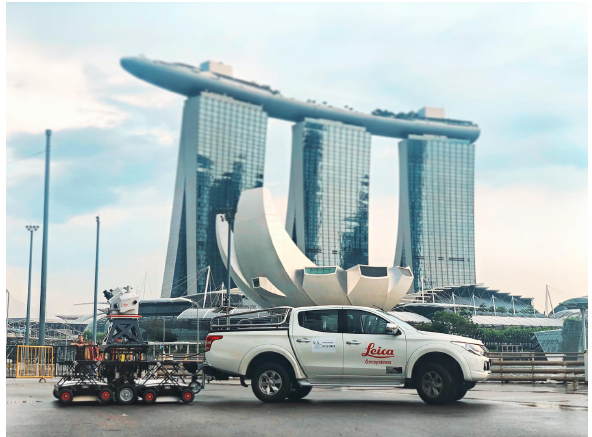
Figure 1. The Pegasus:Stream during its deployment in Singapore.